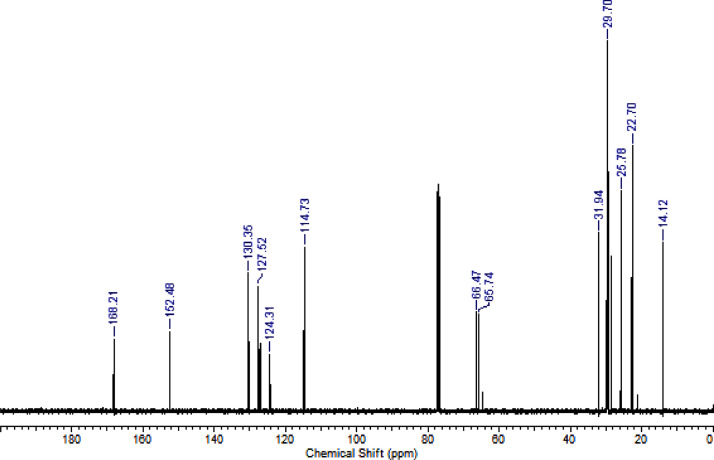
13C NMR (CDCl3, 100 MHz) spectrum of compound 6a.